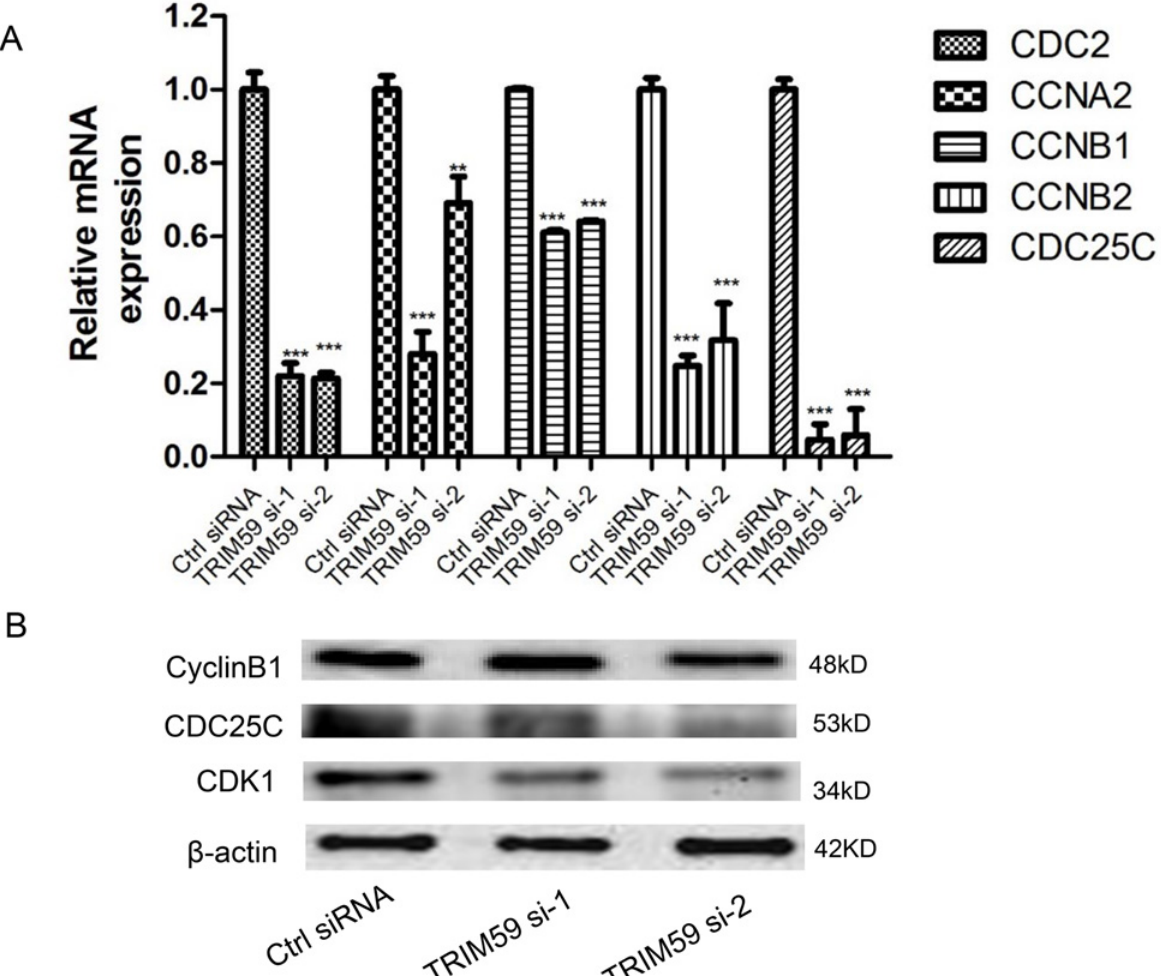
Fig 5. Knocking down of TRIM59 decreased the expression of cell cycle proteins. H1299 cells transiently transfected with TRIM59 siRNA-1, TRIM59 siRNA-2 or control siRNA were cultured in RPMI 1640 with 10% FBS for 48 hrs. (A) The mRNA expression levels of G2/M phase related genes CDC2, CCNA1, CCNB1, CCNB2 and CDC25C were tested by quantitative Real-Time PCR. (B) The protein expression levels of CDK1 (also known as CDC2), CDC25C and cyclin B1 were checked by western blot with indicated